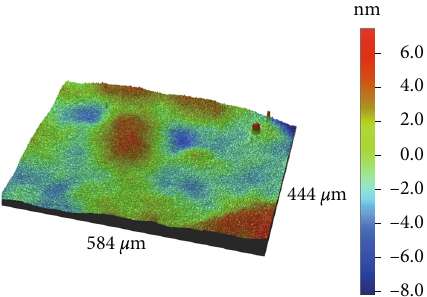
Figure 1: Surface topography of a typical gold-sputtered sample studied in the present work. Results from white light